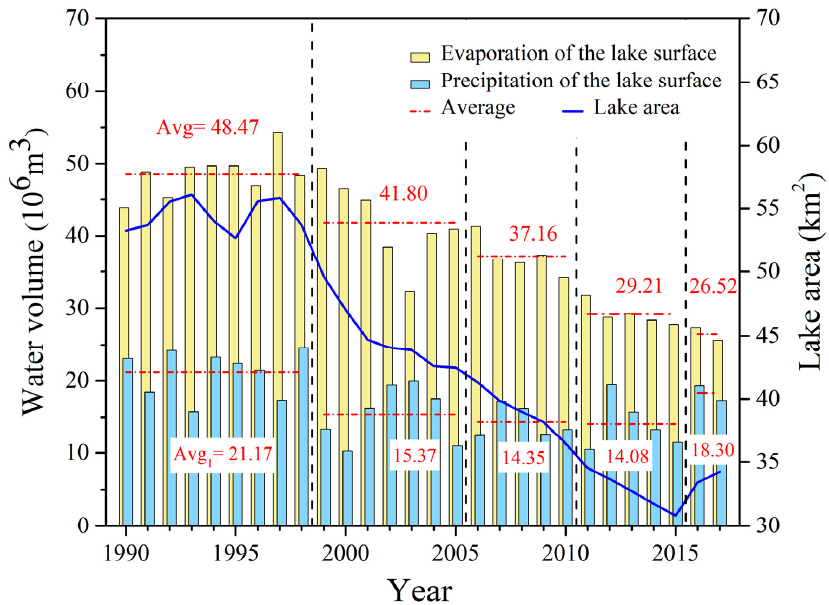
Figure 9. Annual average precipitation and evaporation of the lake surface during 1990–2017. Since HN is an inner-flowing lake, its water is mainly consumed by human activities and lake evaporation. The annual average of water consumed by human activities ( 𝐻 (cid:3028) ) was 37.1 × 10 (cid:2874) m (cid:2871) y (cid:2879)(cid:2869) from 1990 to 1998. The 𝐻 (cid:3028) continued to increase after 1998 and reached a peak of 64.3 × 10 (cid:2874) m (cid:2871) y (cid:2879)(cid:2869) during 2010–2015. In 2016–2017, the 𝐻 (cid:3028) dropped to 59.8 × 10 (cid:2874) m (cid:2871) y (cid:2879)(cid:2869) . The annual average of evaporation of the lake surface ( E (cid:2933) ) was 48.5 × 10 (cid:2874) m (cid:2871) y (cid:2879)(cid:2869) , 41.8 × 10 (cid:2874) m (cid:2871) y (cid:2879)(cid:2869) , 37.2 × 10 (cid:2874) m (cid:2871) y (cid:2879)(cid:2869) , 29.2 × 10 (cid:2874) m (cid:2871) y (cid:2879)(cid:2869) , and 26.5 × 10 (cid:2874) m (cid:2871) y (cid:2879)(cid:2869) in five phases, respectively, which has the same trend with the lake area (Fig- ure 9). The change in the water storage of HN (dV) was caused by the difference of water supply and loss. During 1990–1998, the HN was in a relatively stable state, the annual